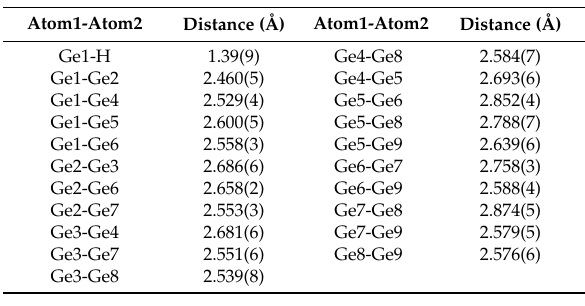
Table 2. Distances [Å] within the anionic moiety [HGe 9 ] 3 − .